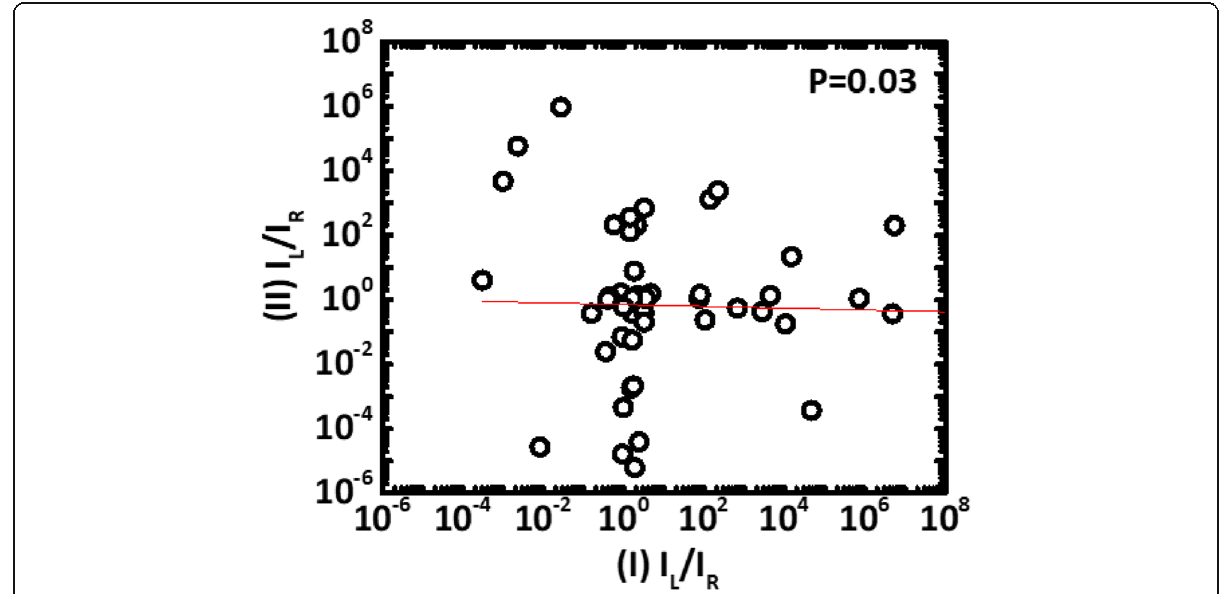
Fig. 8 Leakage current ratio of left and right side of pattern I and II showing there is no systematic misalignment effect from these